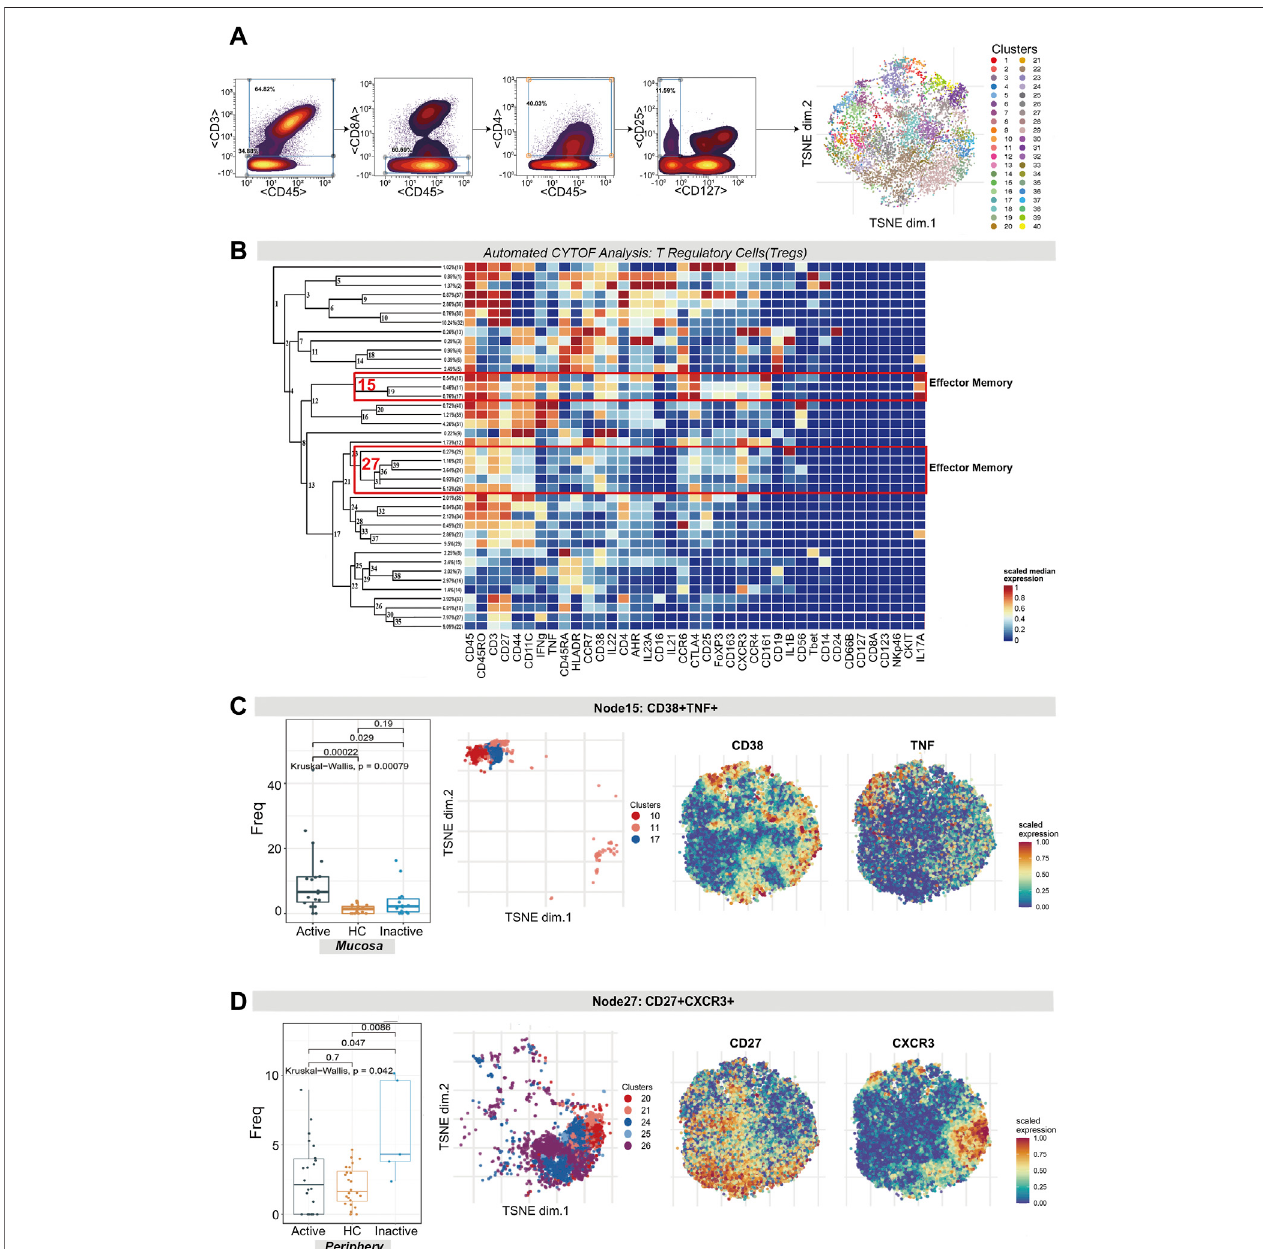
FIGURE 2 | CyTOF analysis revealed the expression of two effector memory Treg subsets in UC patients and HCs. (A) Gating steps (left) and t-SNE plot (right) of selected Tregs. (B) Cluster dendrogram, heatmap and selected nodes of Tregs. (C,D) Abundance boxplots and t-SNE plots of node 15 (C) and node 27 (D) in Tregs, with respective selected marker heatmaps for